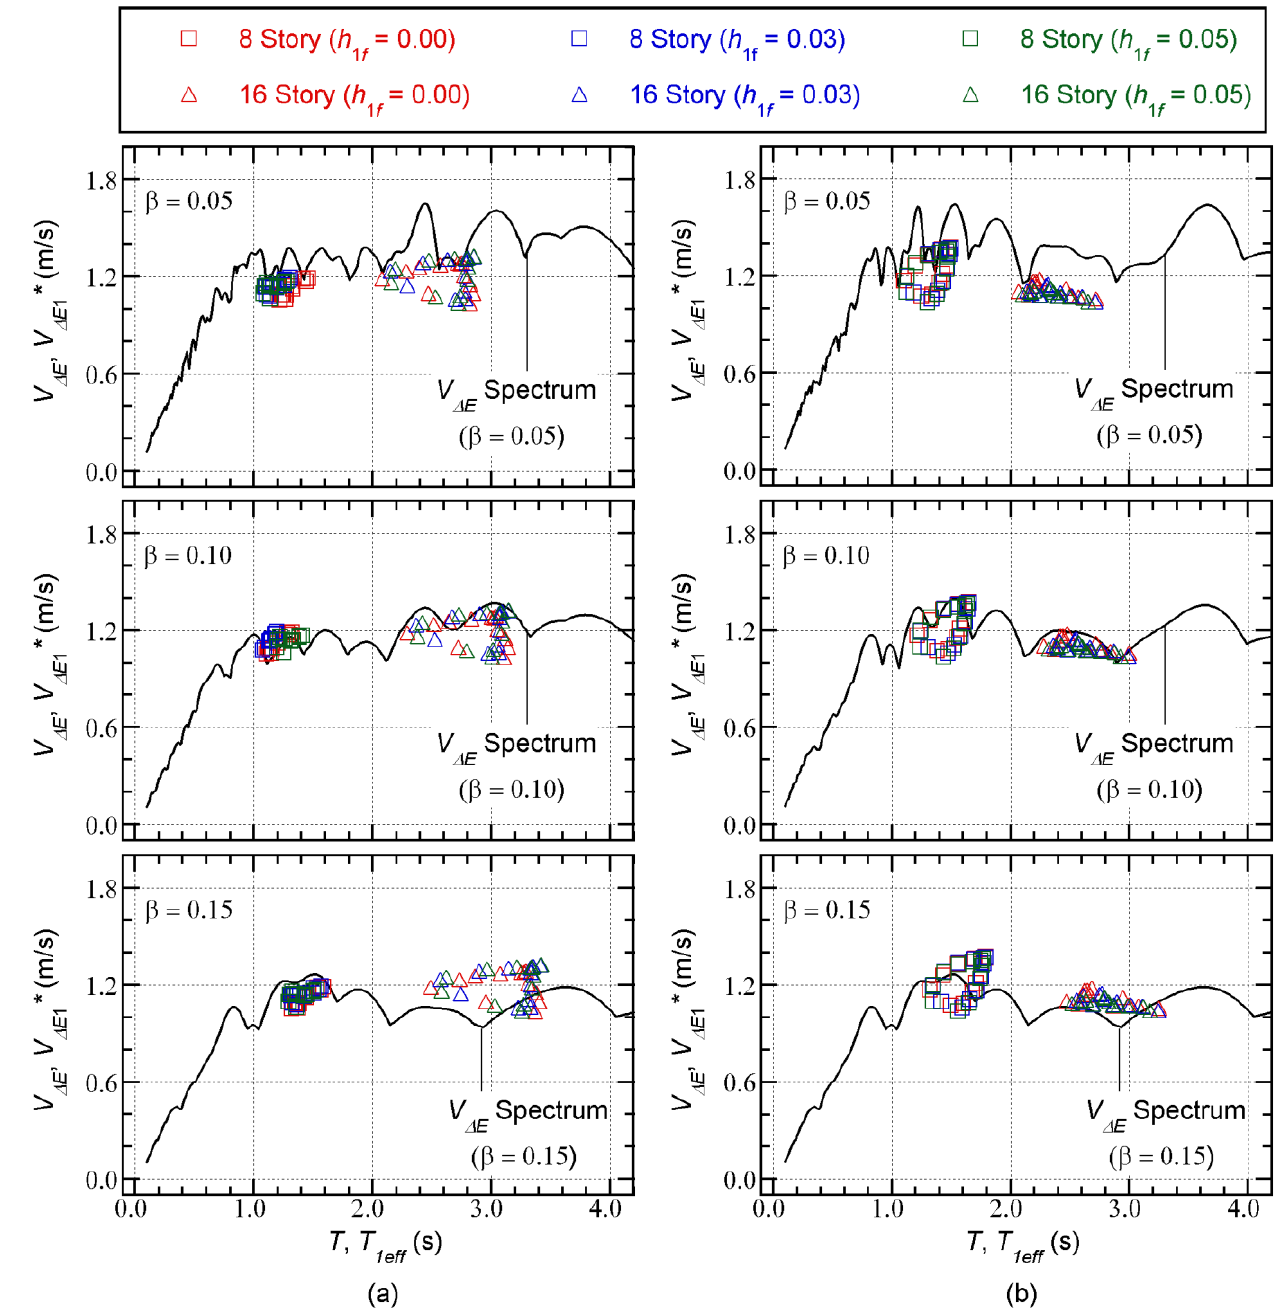
Figure 18. Comparisons of the V ∆ E spectrum and V ∆ E 1 ∗ obtained from the time-history analysis: ( a ) Art-L series; ( b ) Art-S series.